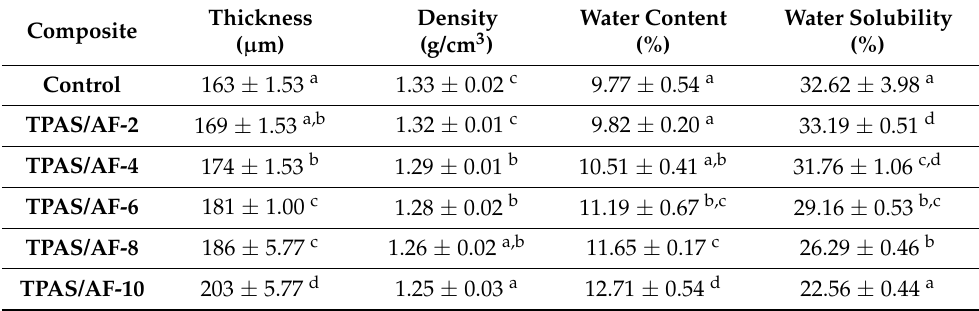
Table 2. Physical performances of the TPAS/AF biocomposite